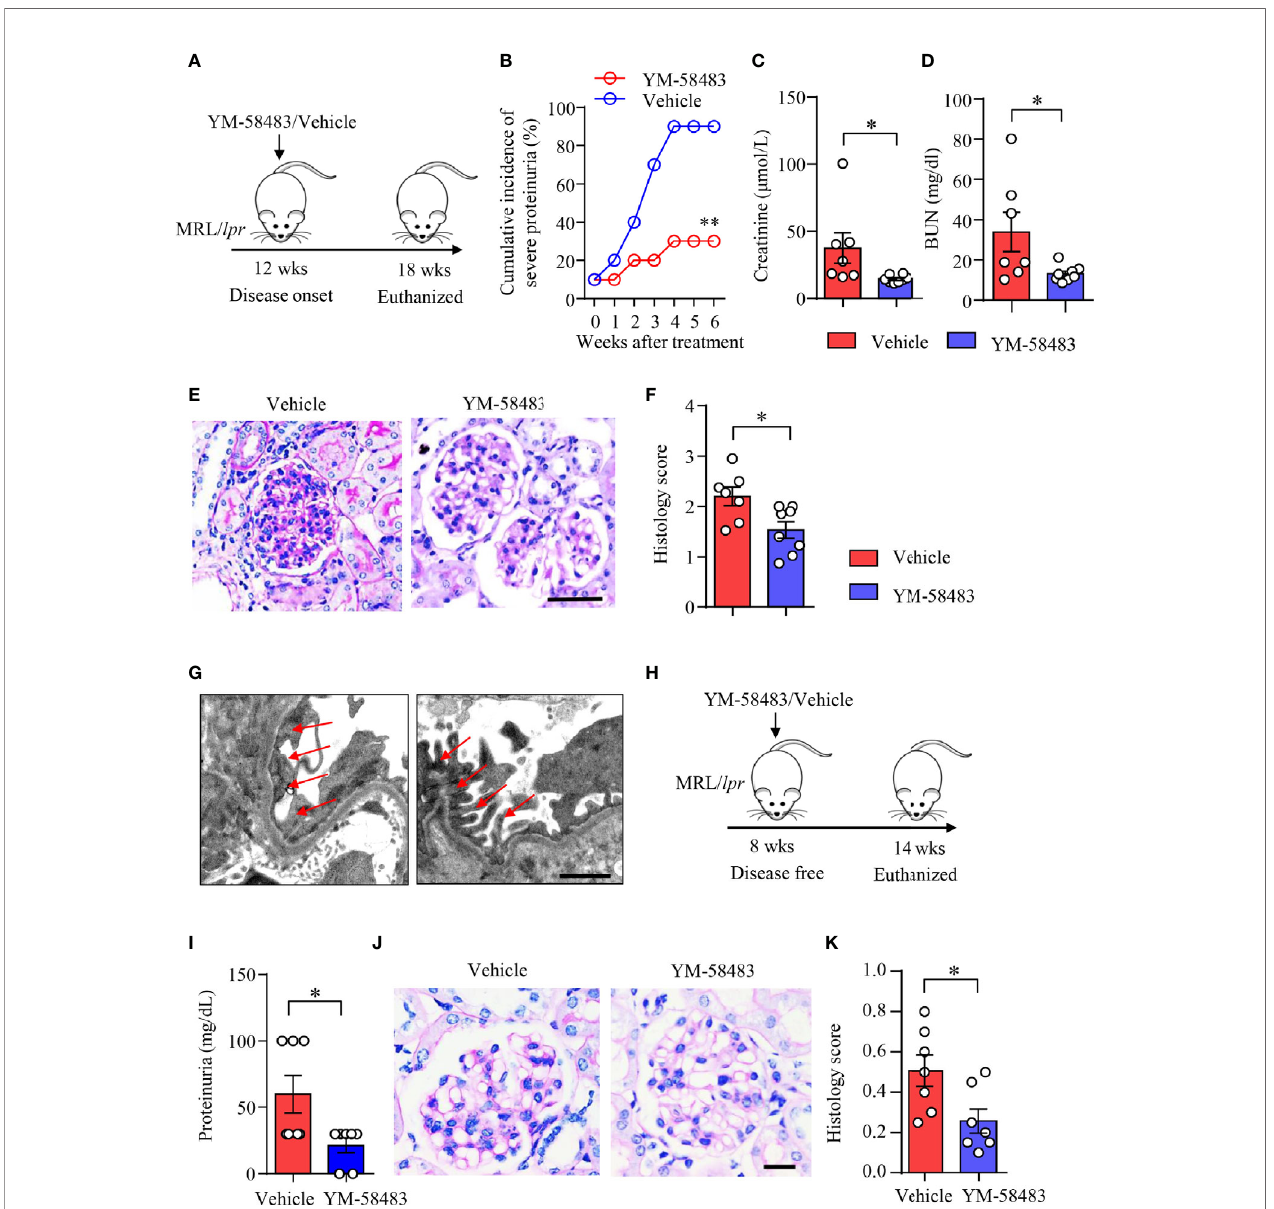
FIGURE 6 | YM-58483 ameliorated kidney damage and improved renal function in MRL/lpr lupus mice. (A) MRL/lpr mice (12-week) were treated with YM-58483 (1 mg/kg) or vehicle intraperitoneal once a day for 6 weeks. (B) Severity of proteinuria of YM-58483- or vehicle-treated mice were monitored and recorded weekly. (C, D) Concentrations of creatinine or blood urea nitrogen (BUN) in the sera. (E) Kidney samples from YM-58483- or vehicle-treated mice were stained with PAS. Scale bar 50 m M. (F) Histology score for PAS staining was summarized, n = 7 in the vehicle group and n = 8 in the YM-58483 group. (G) Kidney samples were prepared for transmission electron microscopy to assess the pathological features of glomeruli. Representative images are shown. Red arrows indicate foot process of podocytes. Scale bar 1 m M. (H) MRL/lpr mice (8-week) were treated with YM-58483 (1 mg/kg) or vehicle intraperitoneal once a day for 6 weeks. (I) Proteinuria of YM-58483- or vehicle-treated mice were recorded in 14 weeks. (J) Kidney samples from YM-58483- or vehicle-treated mice were stained with PAS to assess the pathological features of glomeruli. Scale bar 20 m M. (K) Histology score for PAS staining was summarized. n =7 in the vehicle group and n = 7 in the YM-58483 group. All data are mean ± SEM. *p < 0.05, **p < 0.01 by